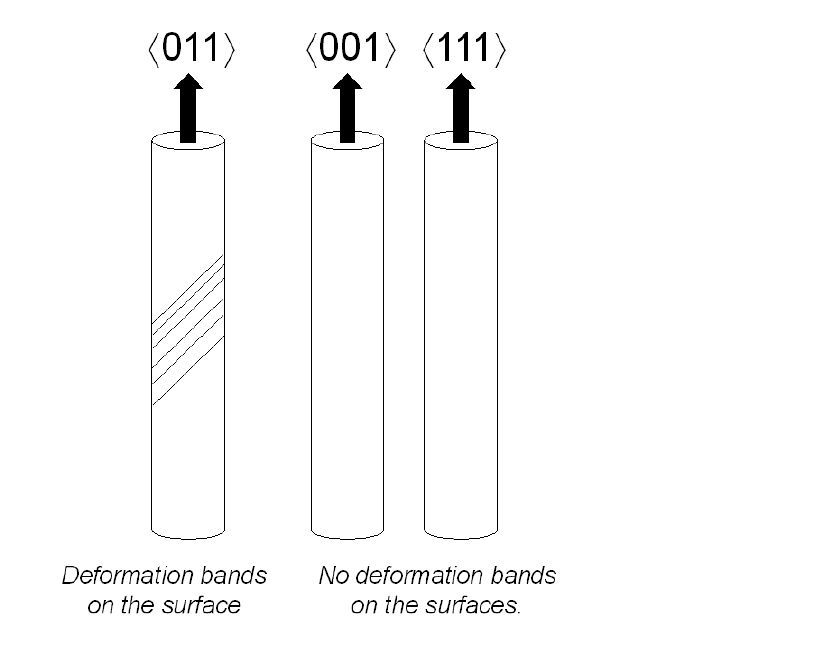
Figure 3. A sketch of the deformation band appearance on the specimen